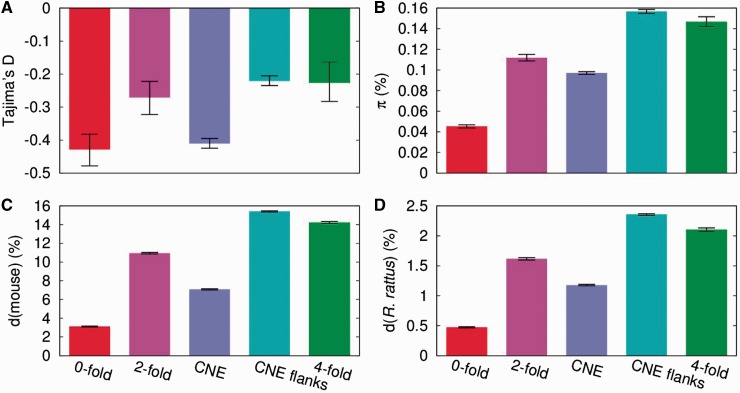
Tajima’s D (A), diversity (B), and divergence from mouse (mm10; C) and Rattus rattus (D) for wild Rattus norvegicus data. Error bars show 95% confidence intervals based on 1,000 bootstrapping replicates. See supplementary material, Supplementary Material online, for impact of proximity filter, exon/CNE selection rules (supplementary figs. S1–S4, Supplementary Material online), and restricting analysis to sites with corresponding R. rattus bases (supplementary table S1, Supplementary Material online).